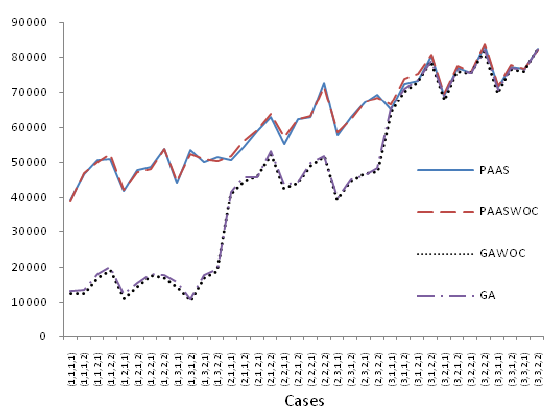
Fig. 2 Average total revenue (mean performance) of the four algorithms across different experimental conditions